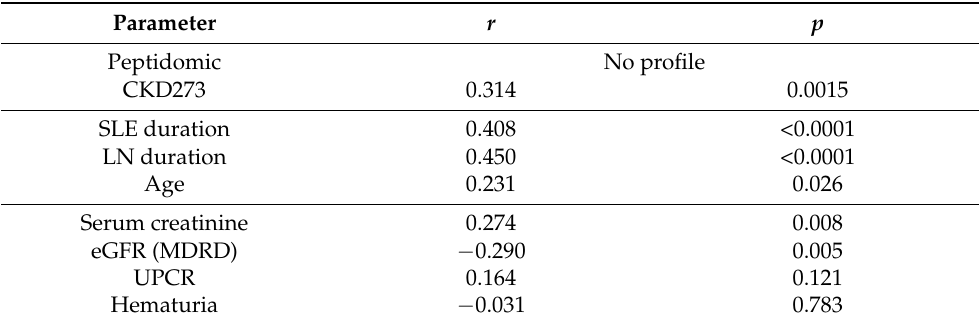
Figure 1. Correlation between Interstitial Fibrosis/Tubular Atrophy and ( A ) CKD273, ( B ) serum creatinine at inclusion, ( C ) SLE duration, ( D ) eGFR at inclusion, ( E ) LN duration and ( F ) age. eGFR: estimate glomelural filtration rate calcutated with the MDRD formula; LN: Lupus Nephritis; SLE: Systemic Lupus Erythematosus. Table 4. Correlation between peptidomic and clinico-biological characteristics with the severity of